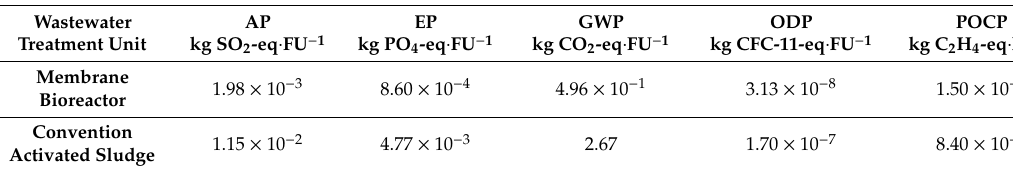
Table 6. LCIA with no sludge removal life cycle contribution.